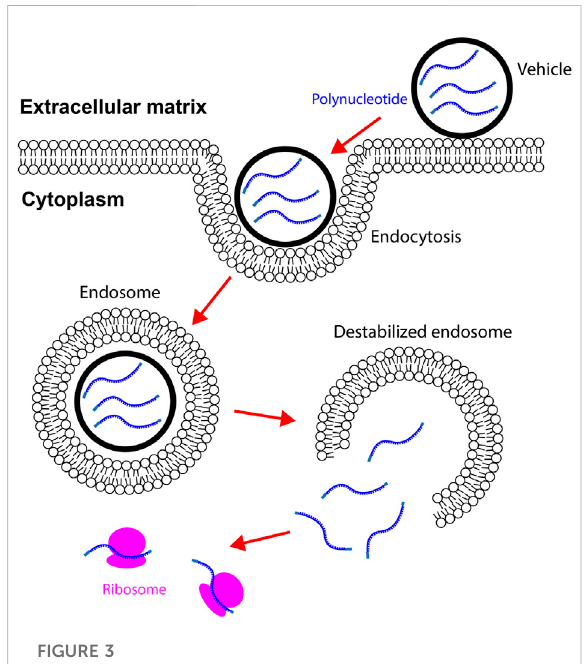
FIGURE 3 Vehicles carrying mRNAs enter the cytoplasm via endocytosis. Vehicles adhere to the cell membrane by binding to speci fi c ligands or via electrostatic forces. Internalization of vehicles is mediated by endocytosis in cardiac cells. Vehicles destabilize endosomes by disrupting the integrity of endosome membrane. mRNAs in vehicles are then released to thecytoplasm. mRNAs are translated to proteins after binding to